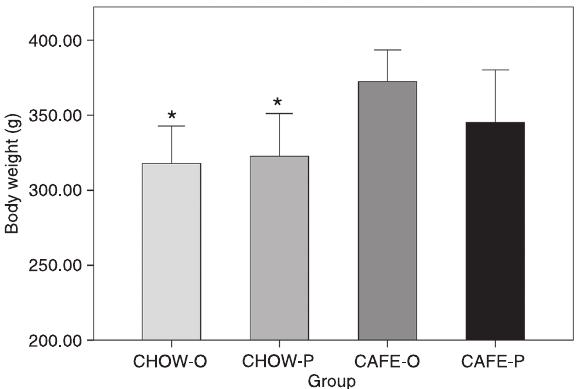
Figure 2. Body weight (means ± SD) at the end of follow-up in the chow-only (CHOW-O), chow-pioglitazone (CHOW-P), cafeteria- only (CAFE-O), and cafeteria-pioglitazone (CAFE-P) groups. *P < 0.05 vs CAFE-O (one-way